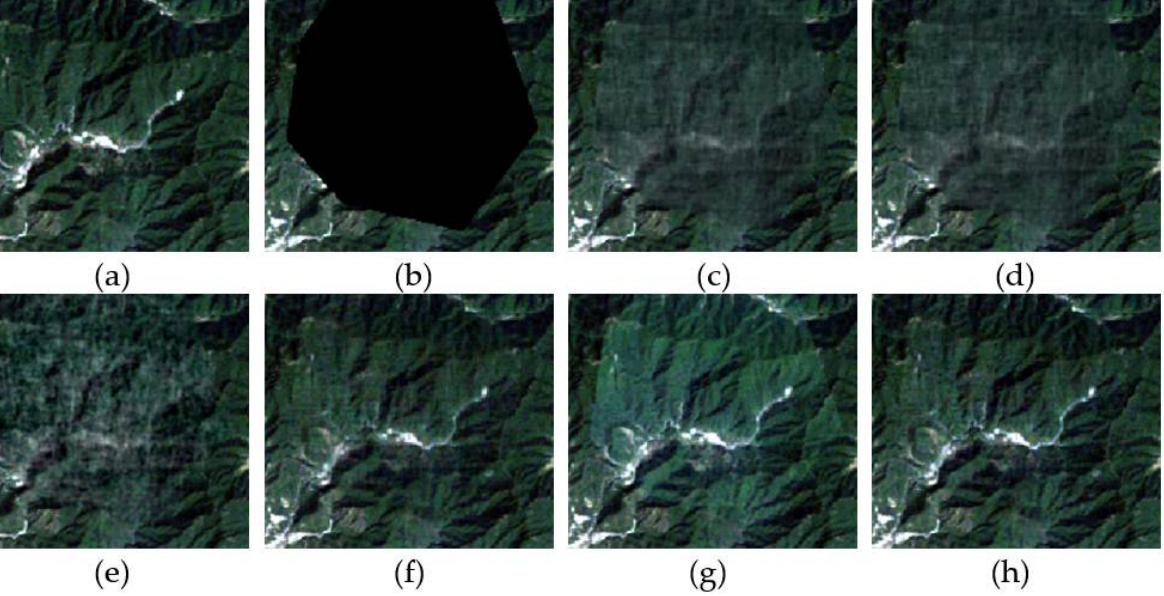
Figure 10. Enhanced details from Figure 9a–h: ( a ) original image; ( b ) simulated cloudy image; ( c – h ) reconstructed images of HaLRTC, AWTC, NL-LRTC, TVLRSD, ST-Tensor and FMTC algorithms, respectively.